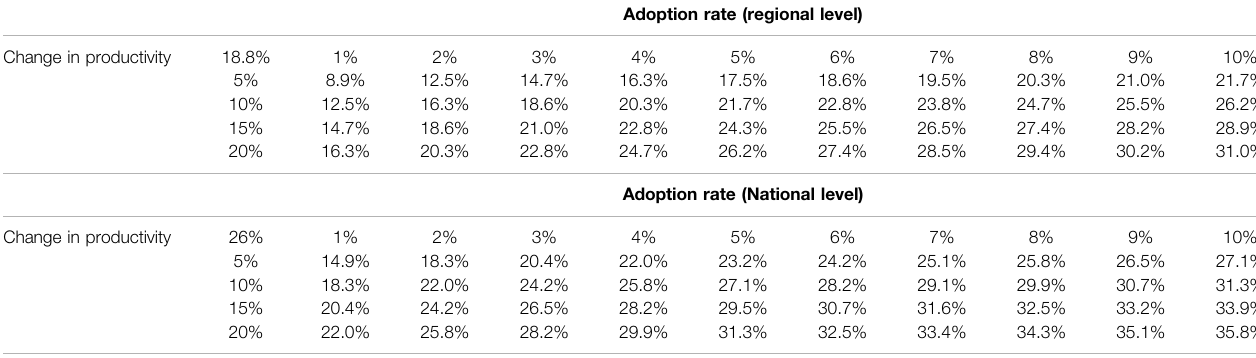
Adoption rate (regional level)